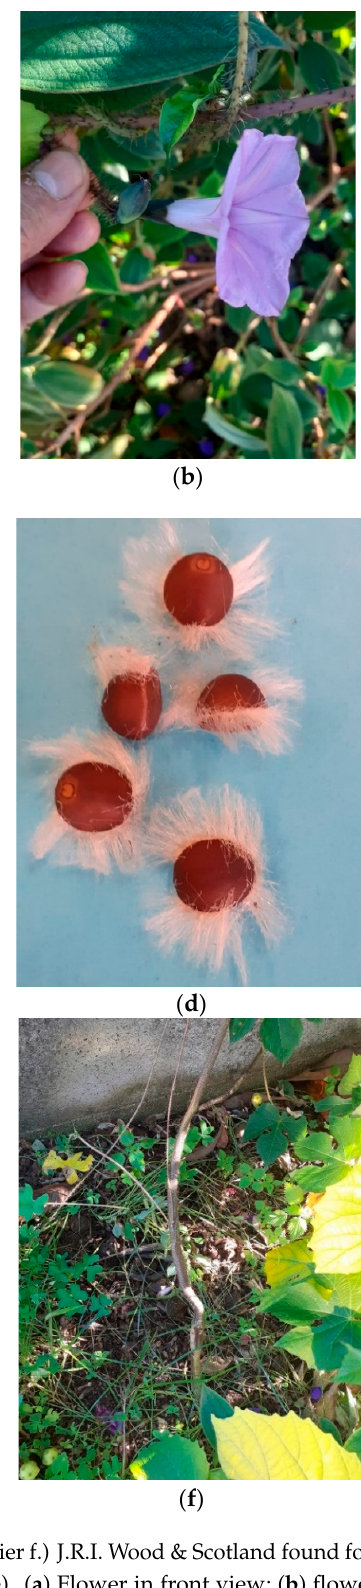
side view; ( c ) stem and leaves; ( d ) hairy seeds; ( e ) location of the new record; ( f ) particular of the low part of